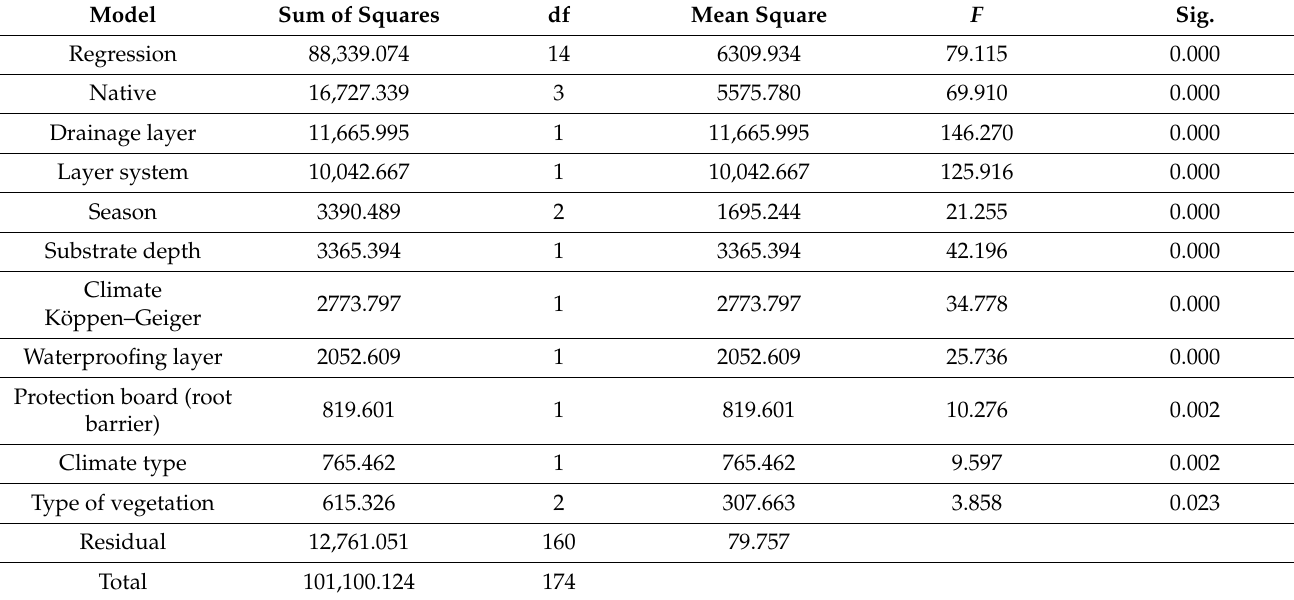
Table 8. ANOVA of the best regression model.